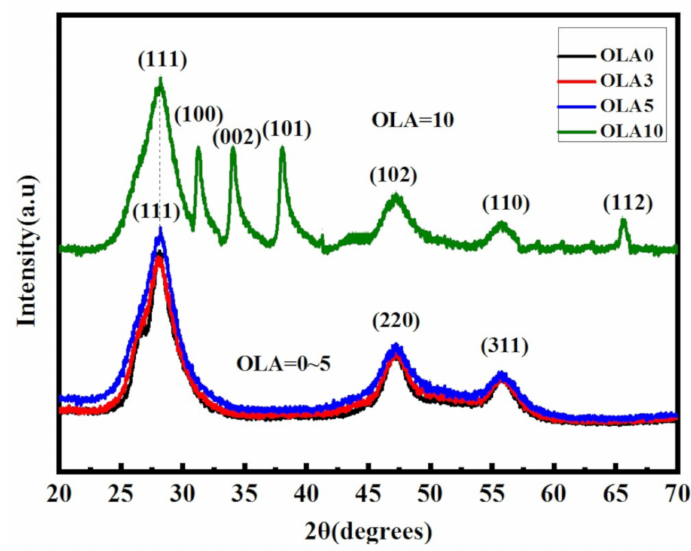
Figure 7. X-ray diffraction (XRD) patterns of core–shell QDs with OLA content.